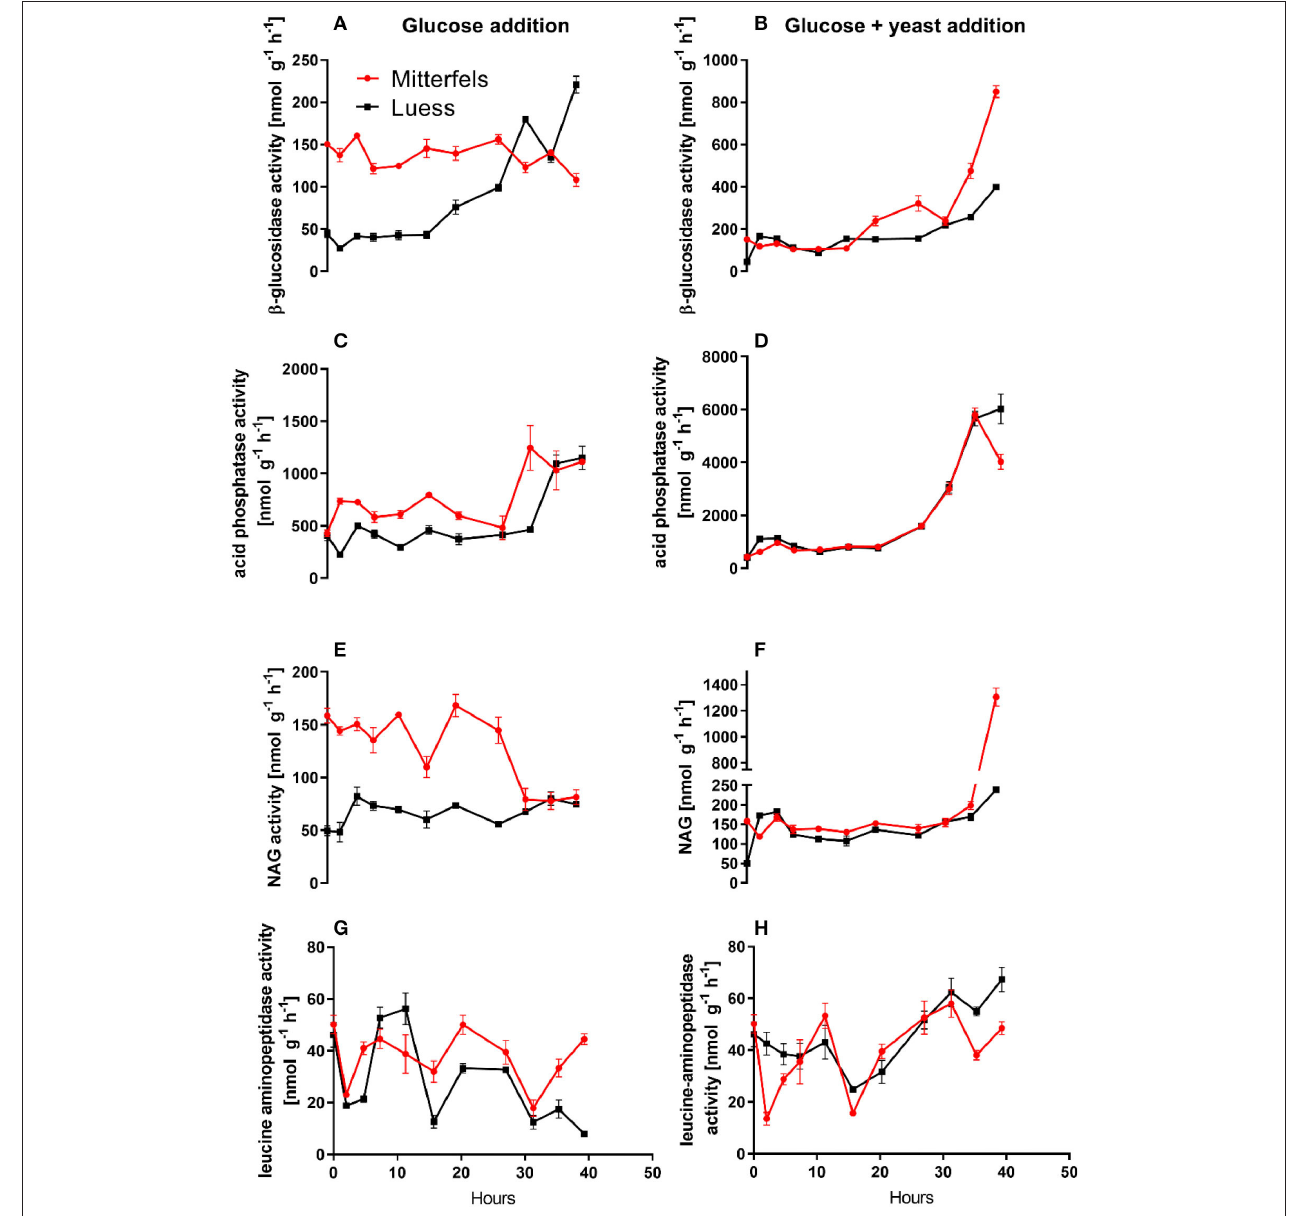
FIGURE 5 | Potential activities (V max ) including standard error of mean of C- N- and P-cycling enzymes during microbial growth and retardation. (A,B) beta-glucosidase, (C,D) acid phosphatase, (E,F) NAG, (G,H) leucine-aminopeptidase.